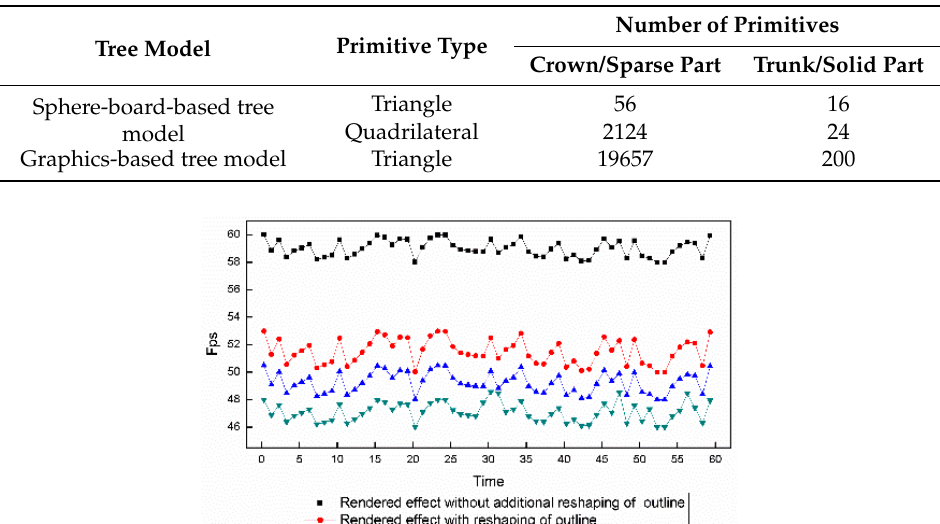
Table 1. Numbers of primitives for the two tree models.